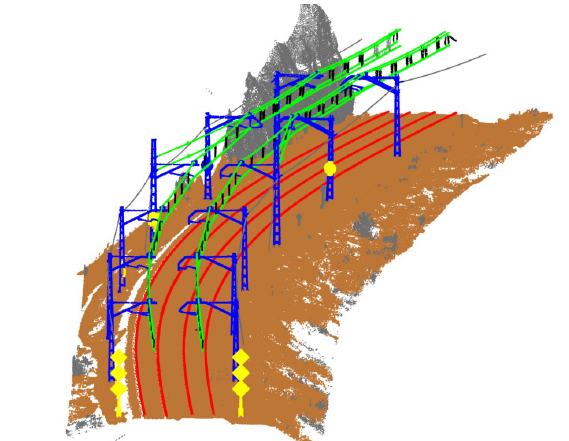
Figure 4. Railway alignment. Rails (coloured in green) are detected and used as a reference to compute the alignment (coloured in red) of the railway lane.